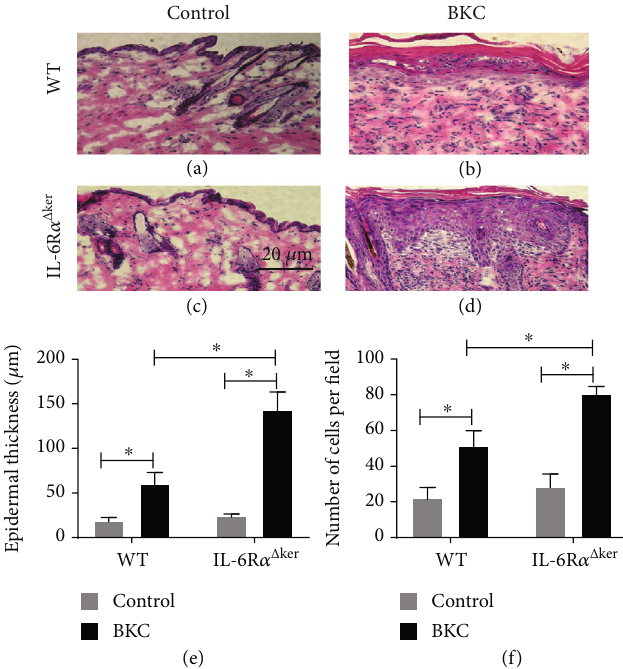
Figure 1: IL-6R α Δ ker mice present with increased epidermal hyperplasia following irritant exposure. Loss of the IL-6R α in keratinocytes promotes epidermal hyperplasia during irritant contact dermatitis. WT and IL-6R α Δ ker mice were exposed to BKC or control for seven (7) consecutive days to induce ICD. 24 hours after irritant exposure, 8 mm biopsies of lesional skin were collected and embedded in O.C.T. compound for histological analysis. Skin samples were cross-sectioned and then hematoxylin and eosin (H&E) stained. Representative H&E stains from WT (a, b) and IL-6R α Δ ker (c, d) are shown. Quanti fi cation of epidermal thickness (e) and cells per fi eld (f) as determined by ImageJ (NIH) is presented. Data are mean ± SD . ∗ Signi fi cantly di ff erent from WT ( p ≤ 0 : 05 , n = 15